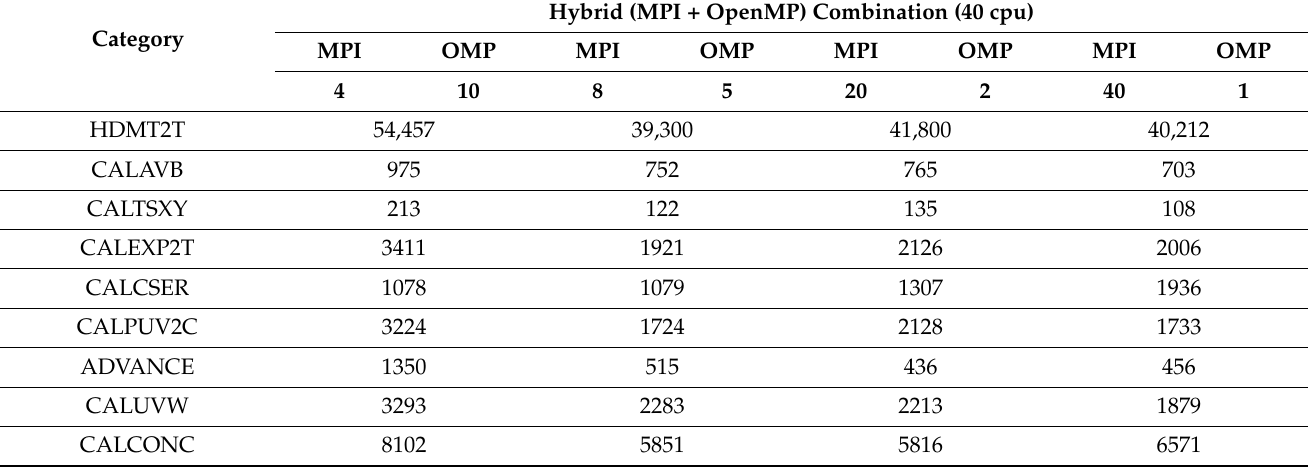
Table A8. Execution time for each function based on the hybrid combination.